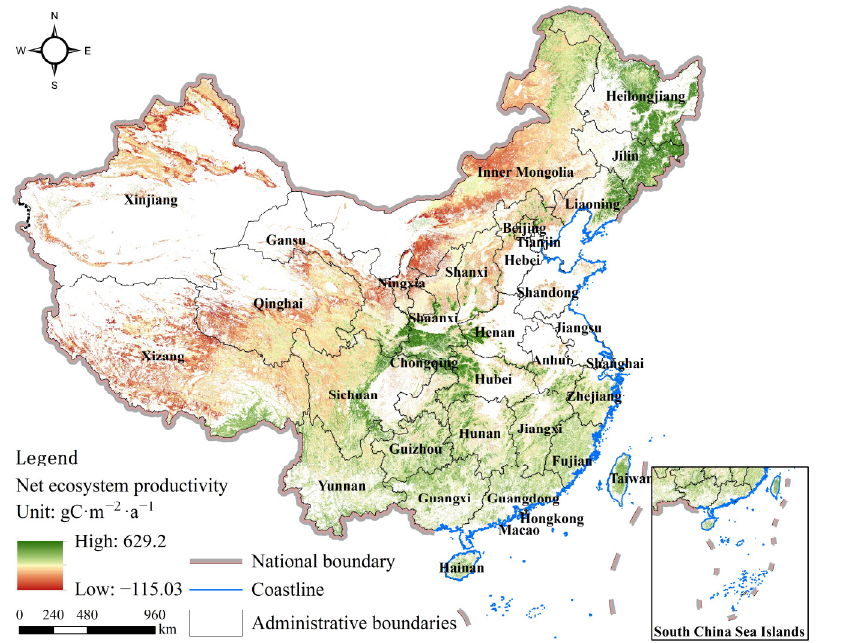
Figure 5. Spatial distribution of cumulative NEP of CES.